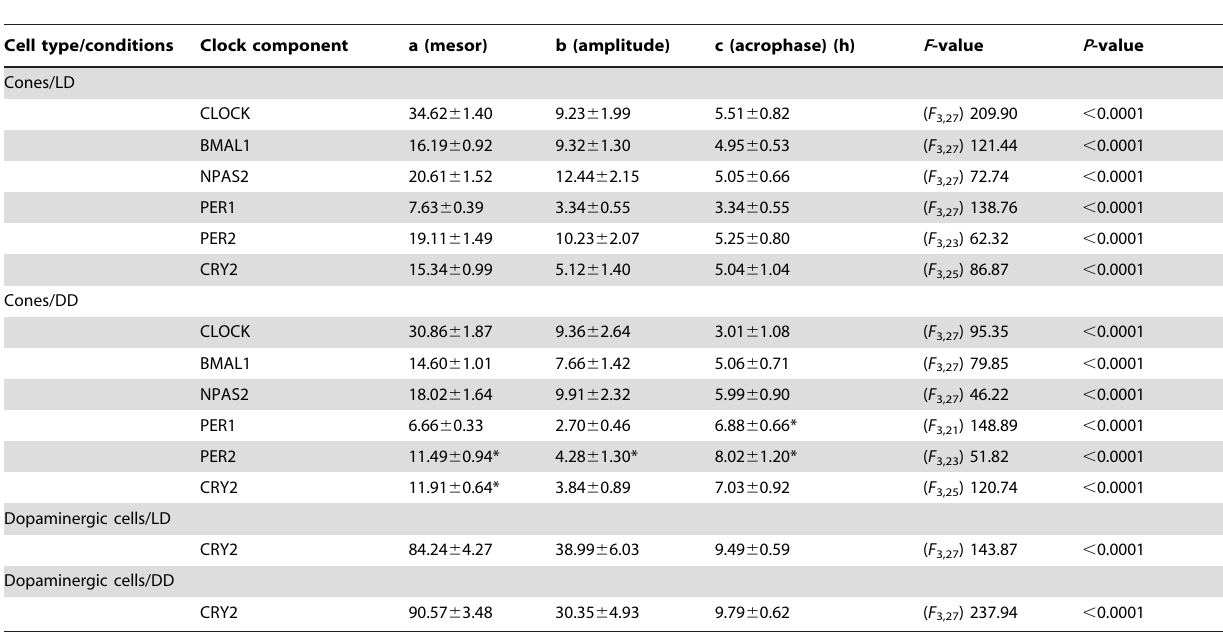
Table 4. COSINOR analysis of core circadian clock component expression in cones and dopaminergic amacrine cells.